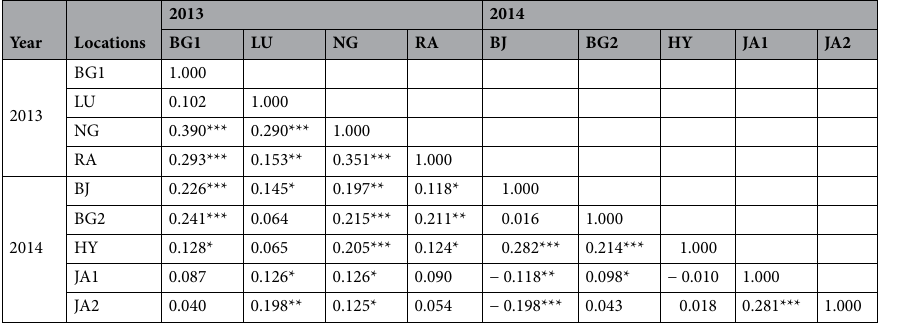
Table 2. Correlation between grain yield at different locations under heat stress. *** , ** , *Statistical significance at p < 0.10, 0.01 and